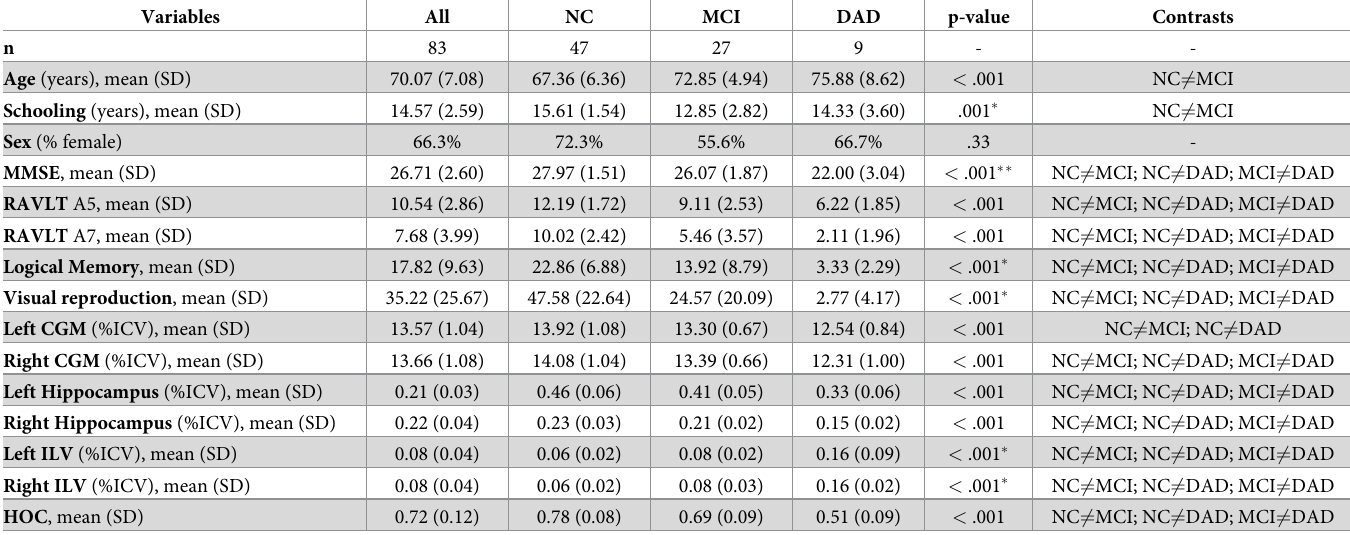
Table 1. Sociodemographic characteristics, mean scores in cognitive assessment and brain volumes, corrected for intracranial volumes of the sample.